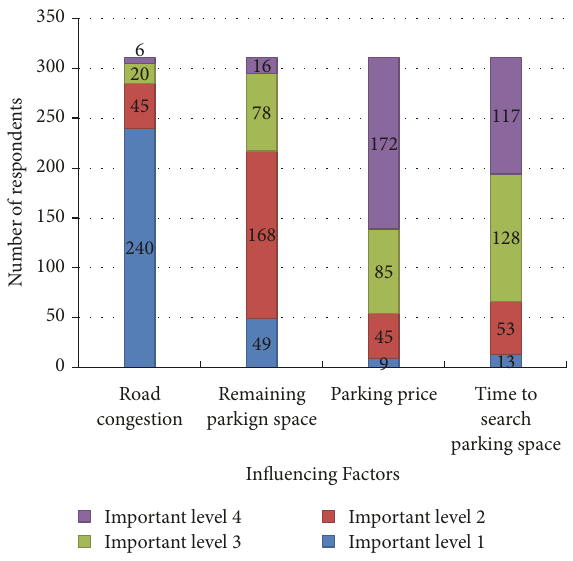
Figure 6: Importance levels of factors that affect departure time.